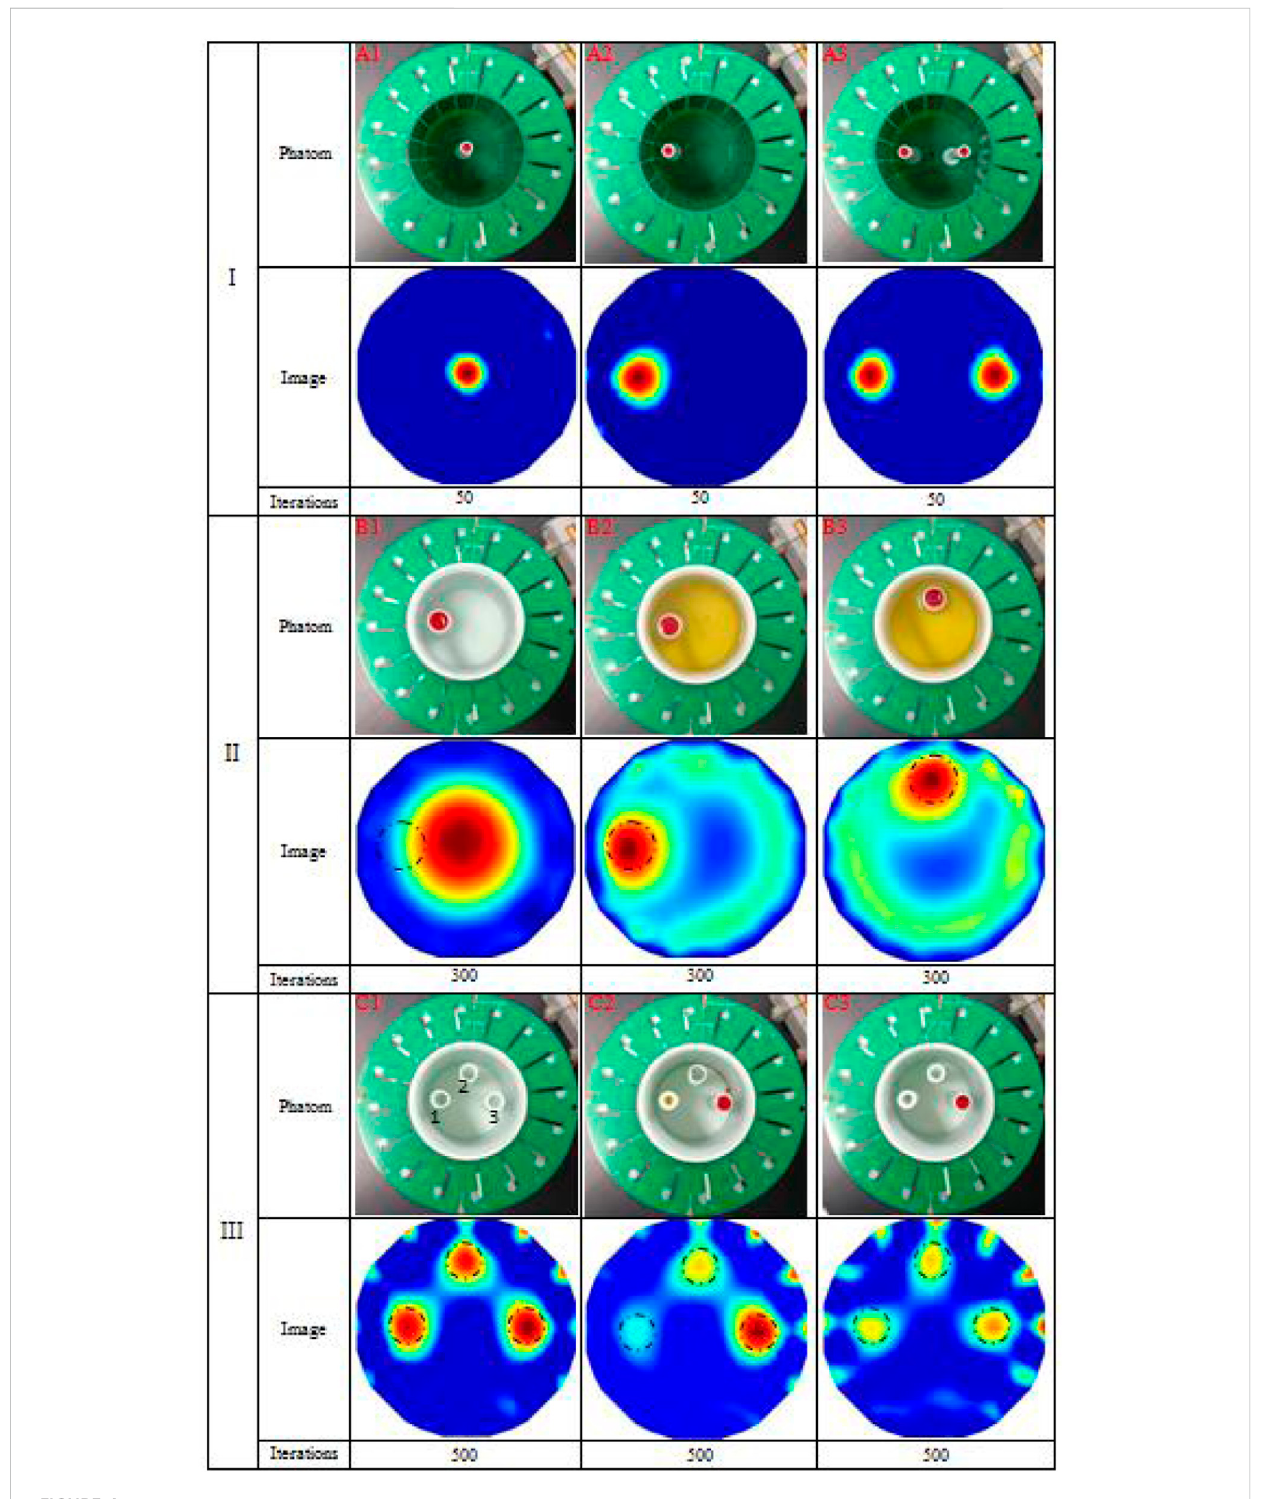
FIGURE 4 Physical experimental models and imaging